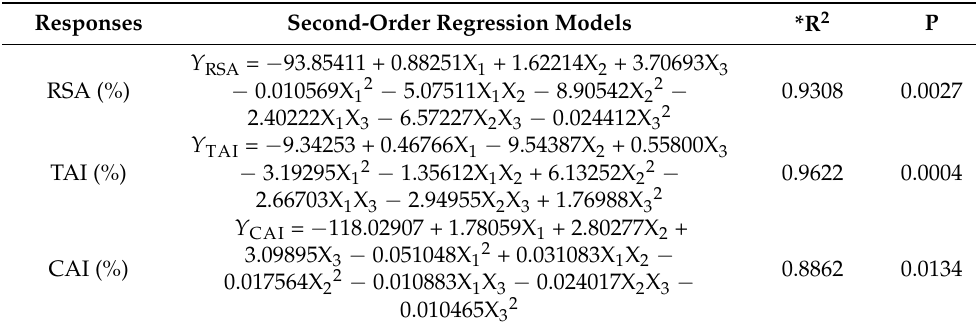
Table 3. Polynomial regression equations calculated by CCD for the optimization of UAE conditions of peanut